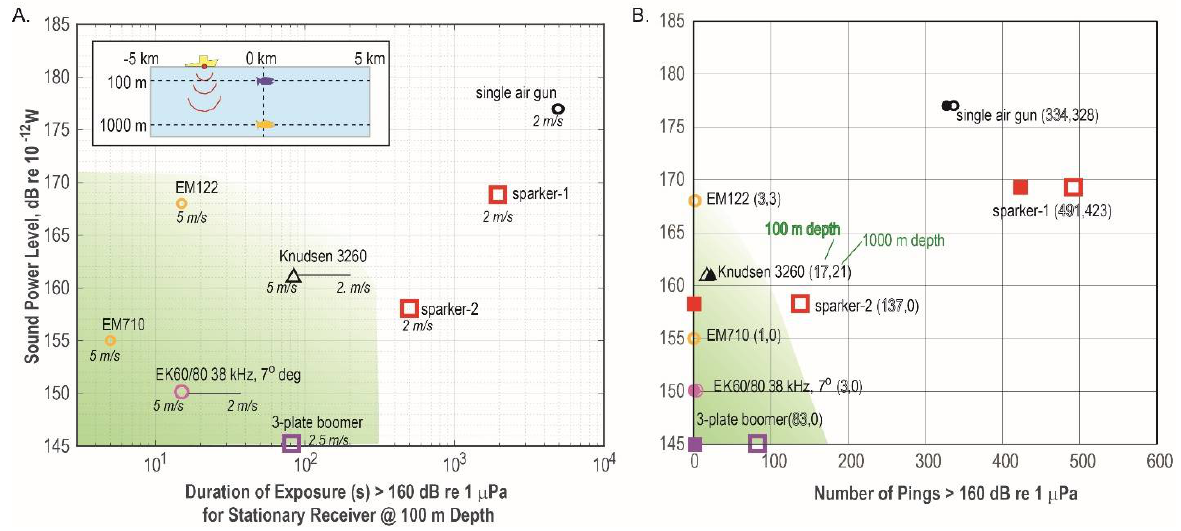
Figure 10. ( A ) Sound power level (radiated power) and duration of exposure (includes quiet period between pings) for “pings” above 160 dB re 1 μPa for a stationary animal at 100 m water depth and 0 m distance as a source is towed by a ship moving from −5 km to 5 km relative to a stationary animal. Additional information is summarized in Table S2 The geometry for the models is shown on the inset diagram, which is not to scale. The source is shown as the red circle on the ship’s hull although the models are applied to both towed and hull-mounted sources. For the main diagram, the color coding of sources is the same as in Figure 5. The range of sources includes both impulsive (airgun, sparker) and non-impulsive sources (EM122, EM710, EK60/80, Knudsen 3260; Table 1). Sparker-1 and Sparker-2 refer to the Delta sparker operated at 6 kJ (deeper water surveys) and the SIG ELC 820 sparker operated at 700 J (e.g., usually at water depths less than 500 m), respectively. The speed indicated in italics next to each point denotes the vessel speed, which is linearly related to the duration of exposure. The 5 m/s (9.7 knots) values for the EM122, EM710, Knudsen 3260, and EK60/80 (base models) are calculated with the sound sources coordinated to emit pulses every 5 s. The Knudsen 3260 and EK60/80 are often operated on slower vessels, and the corresponding scaling to 2 m/s is shown by the line extending to 2.5 times the original duration of exposure for these sources for the same pulse repetition rate. Note that faster pulse repetition would not increase the duration of the exposure and that pulse length is not a factor for the degree of exposure metric defined here. Green shading schematically shows grouping of sources that could be considered de minimis , but does not imply that we assign quantitative limits for radiated power or duration of exposure for de minimis sources under Factor 5. ( B ) For the same sources as in ( A ), radiated power is shown along with the number of pings exceeding 160 dB re 1 μPa for the base models. The number of pings above the threshold is given in parentheses after the source name. Open symbols and labels (first number in parentheses) represent the stationary animal at 100 m depth, and the closed symbols and solid labels (second number in parentheses) are for animals at 1000 m depth. Where only a single symbol is shown, the number of pings above the threshold received at the two depths is indistinguishable. For the Knudsen 3260, more pings above the threshold are received at 1000 m depth than at 100 m depth. Faster pulse repetition rate for any source would increase the number of pings above the threshold. Schematic green shading as in panel ( A